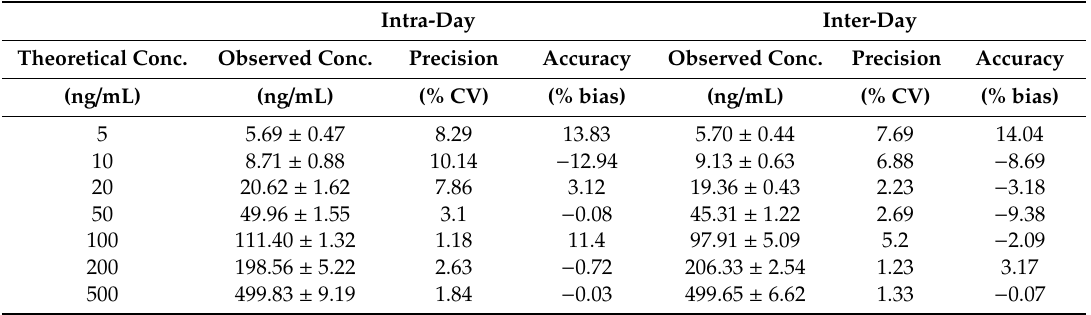
Table 1. Intra-day and inter-day precision and accuracy of LC-MS / MS method for the determination of Erinacine S. Intra-Day Inter-Day Theoretical Conc. Observed Conc. Precision Accuracy Observed Conc. Precision Accuracy (ng / mL) (ng / mL)